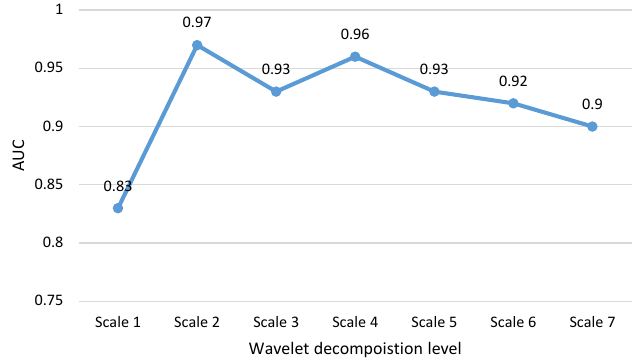
Figure 12. Detection performance of WaveletLSTM at different